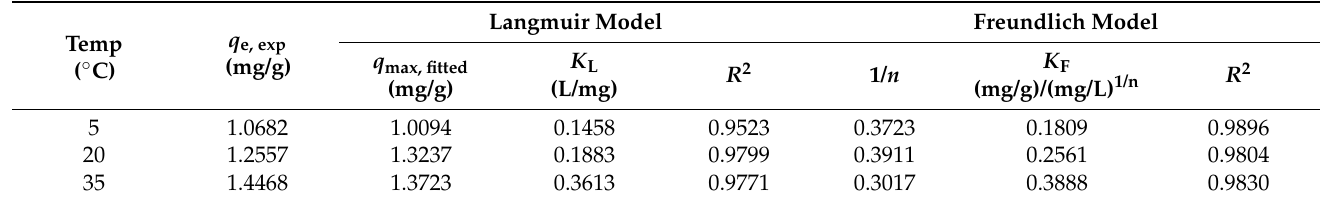
Table 4. Parameters of adsorption isotherm models of bio-ceramsite at different temperatures.